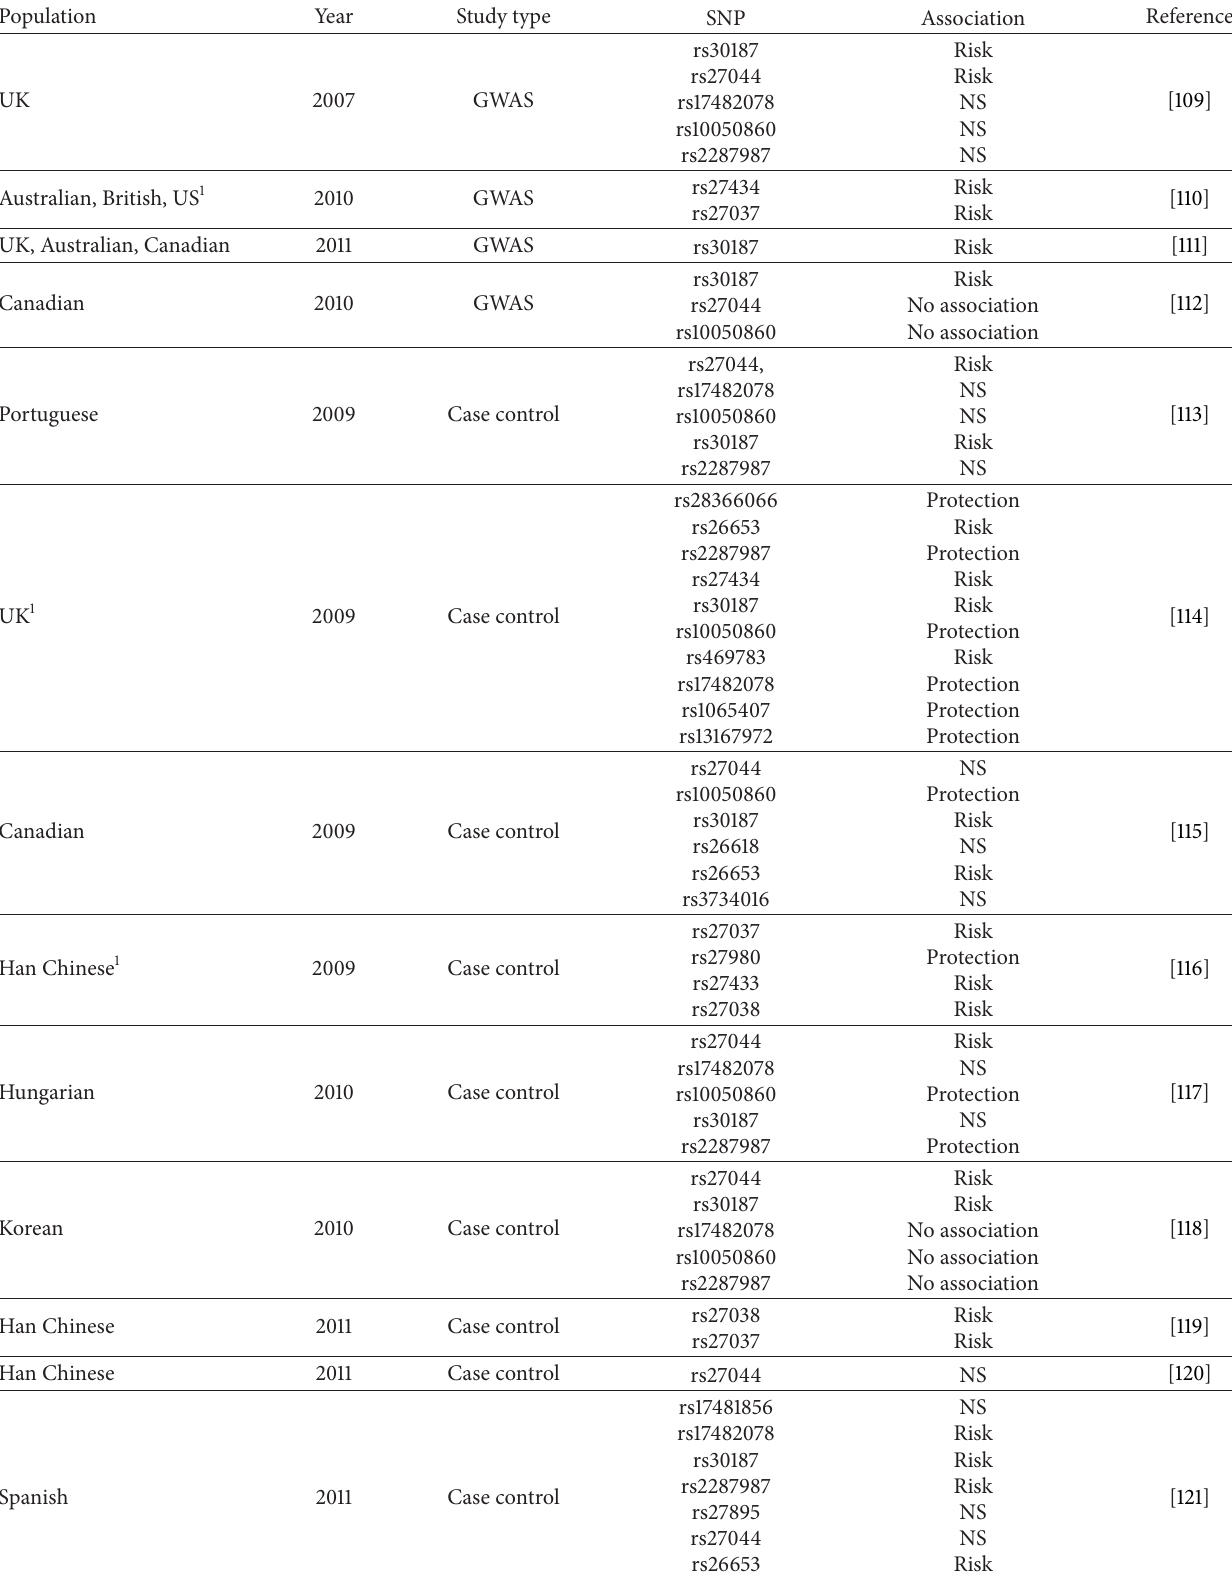
Table 3: Association studies for ERAP1 and ankylosing